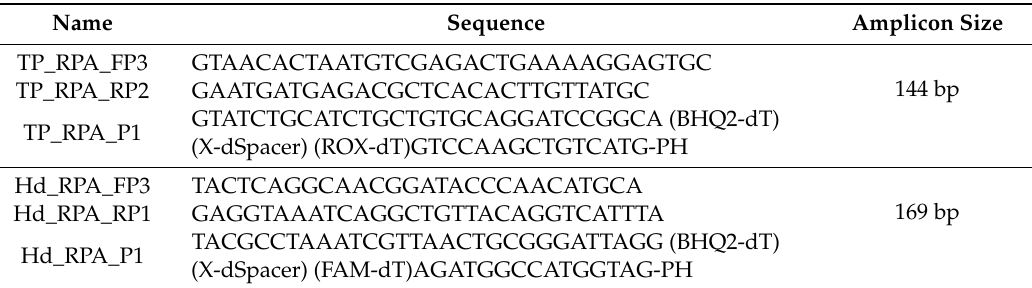
Table 1. RPA Primer and Probe for T. pallidum and H. ducreyi